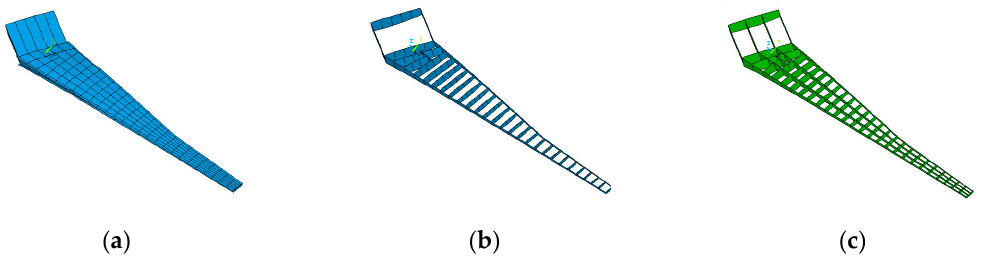
Figure 2. ( a ) Outer geometry of the wing; ( b ) inner 2-spar wing structure; ( c ) inner 4-spar wing structure.